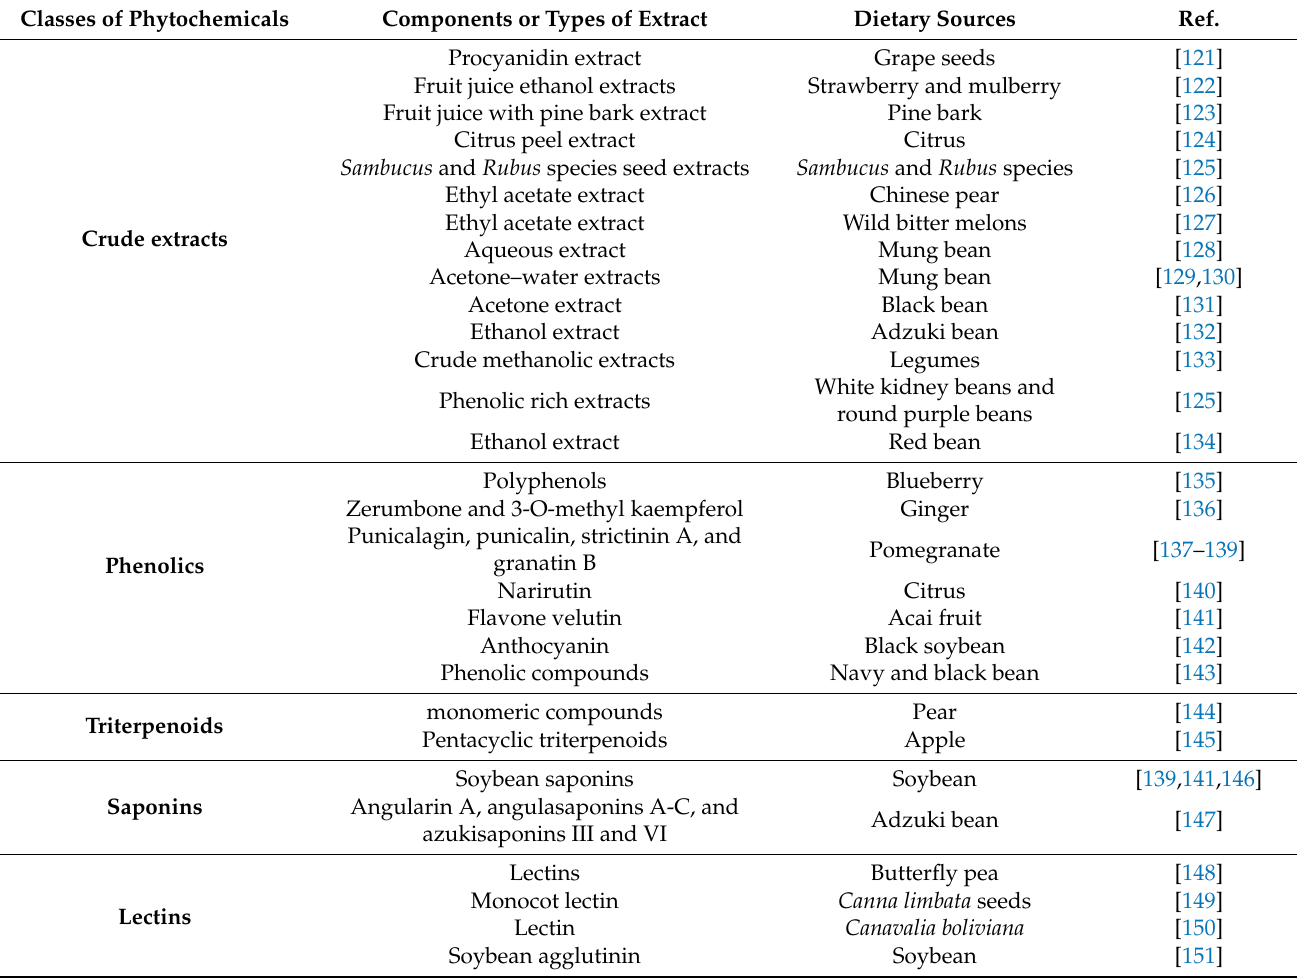
Table 2. Anti-inflammatory effects of phytochemicals from fruits, vegetables, and food legumes. Classes of